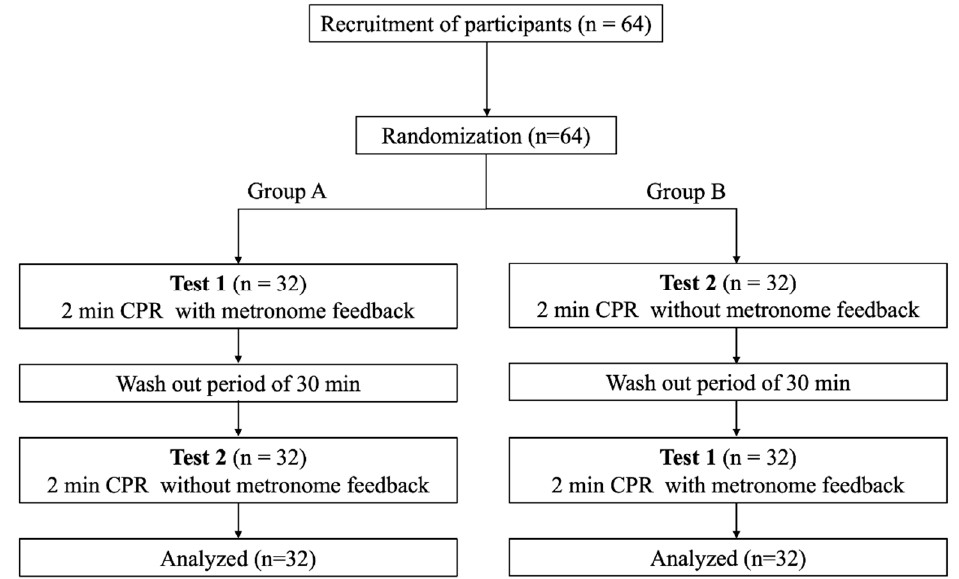
Figure 2. Study design. CPR: cardiopulmonary resuscitation.